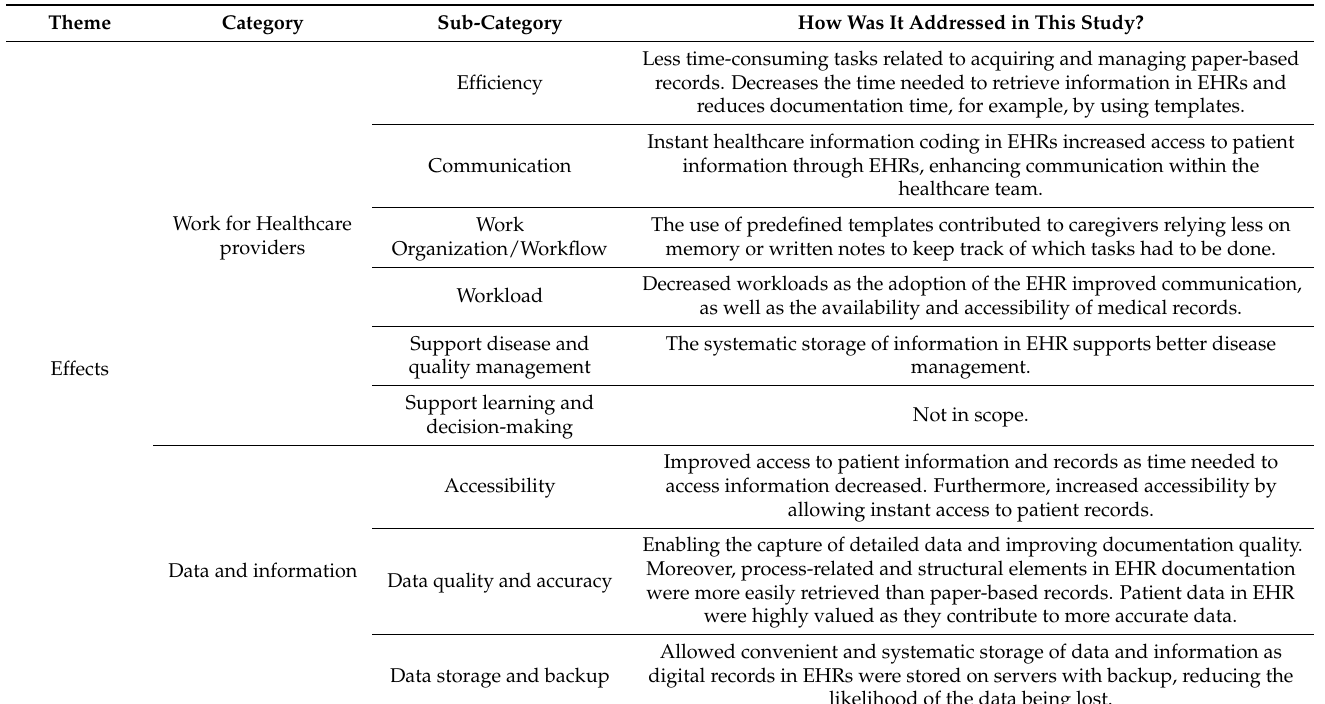
Table 3. The addressed challenges in the implementation of the current solution